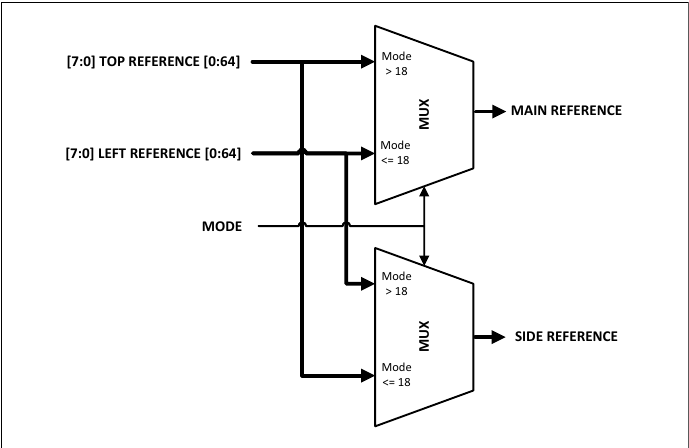
Figure 9. The method to select main and side